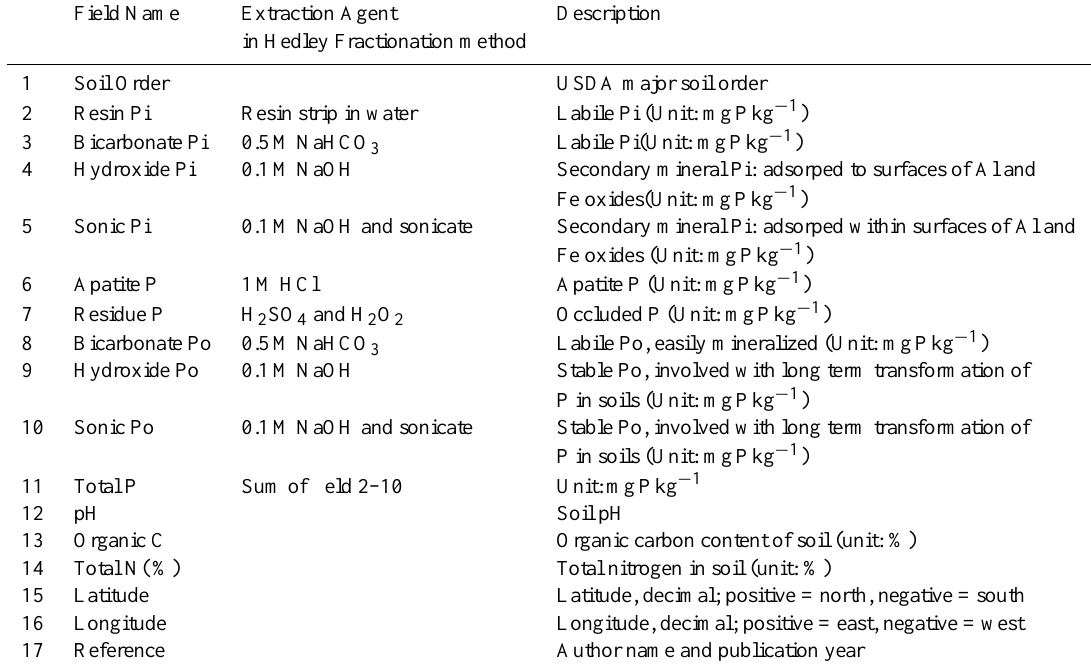
Table 1. Database fields and descriptions.